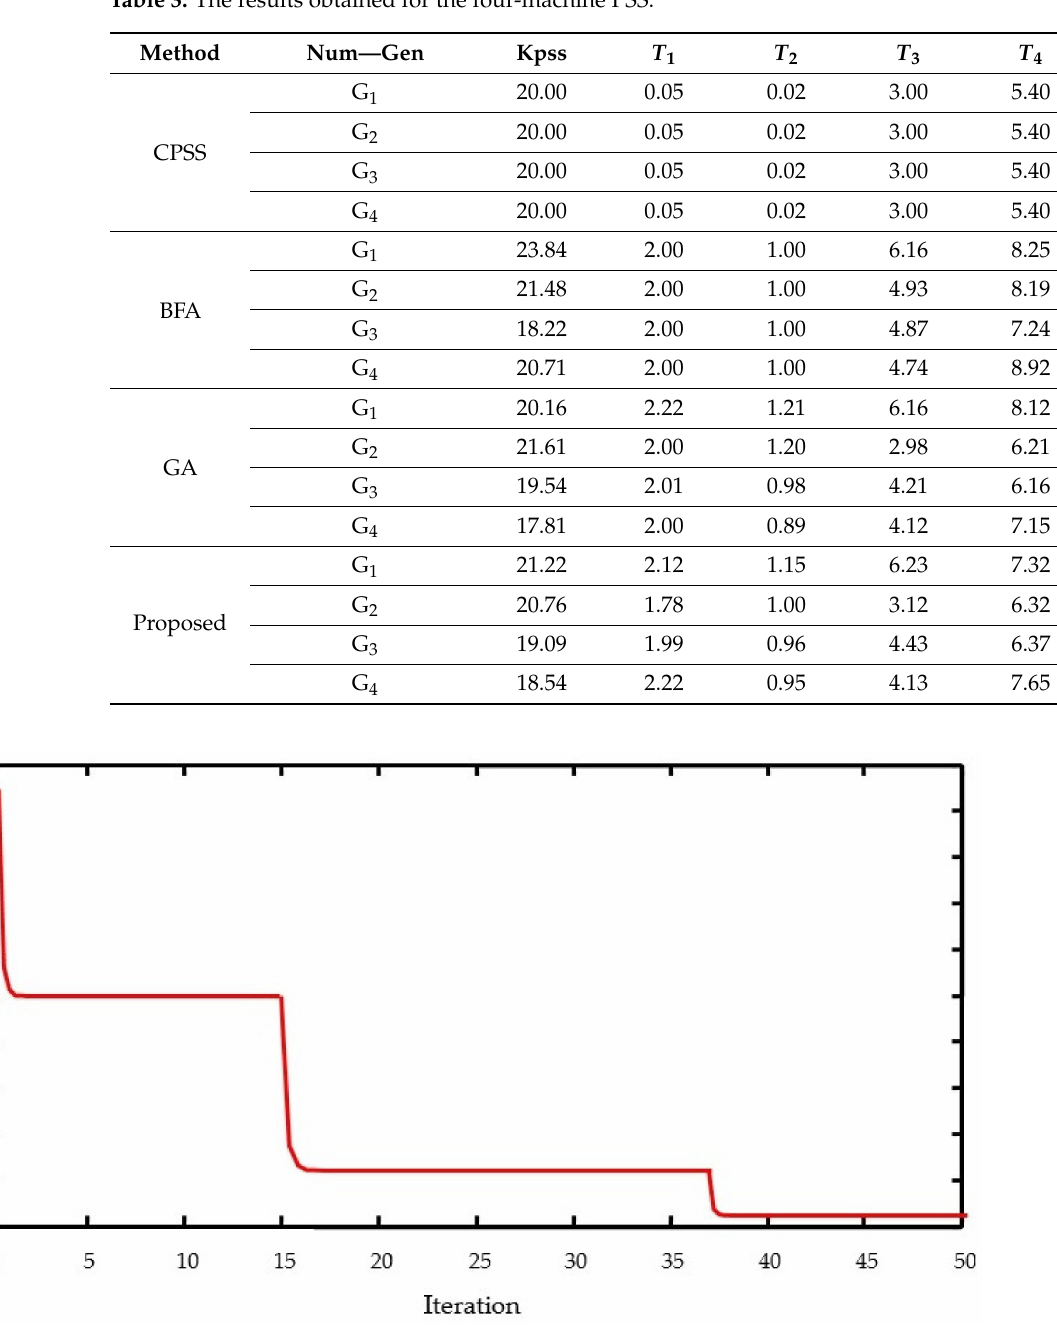
Figure 5. Convergence changes of the four-machine system in the first